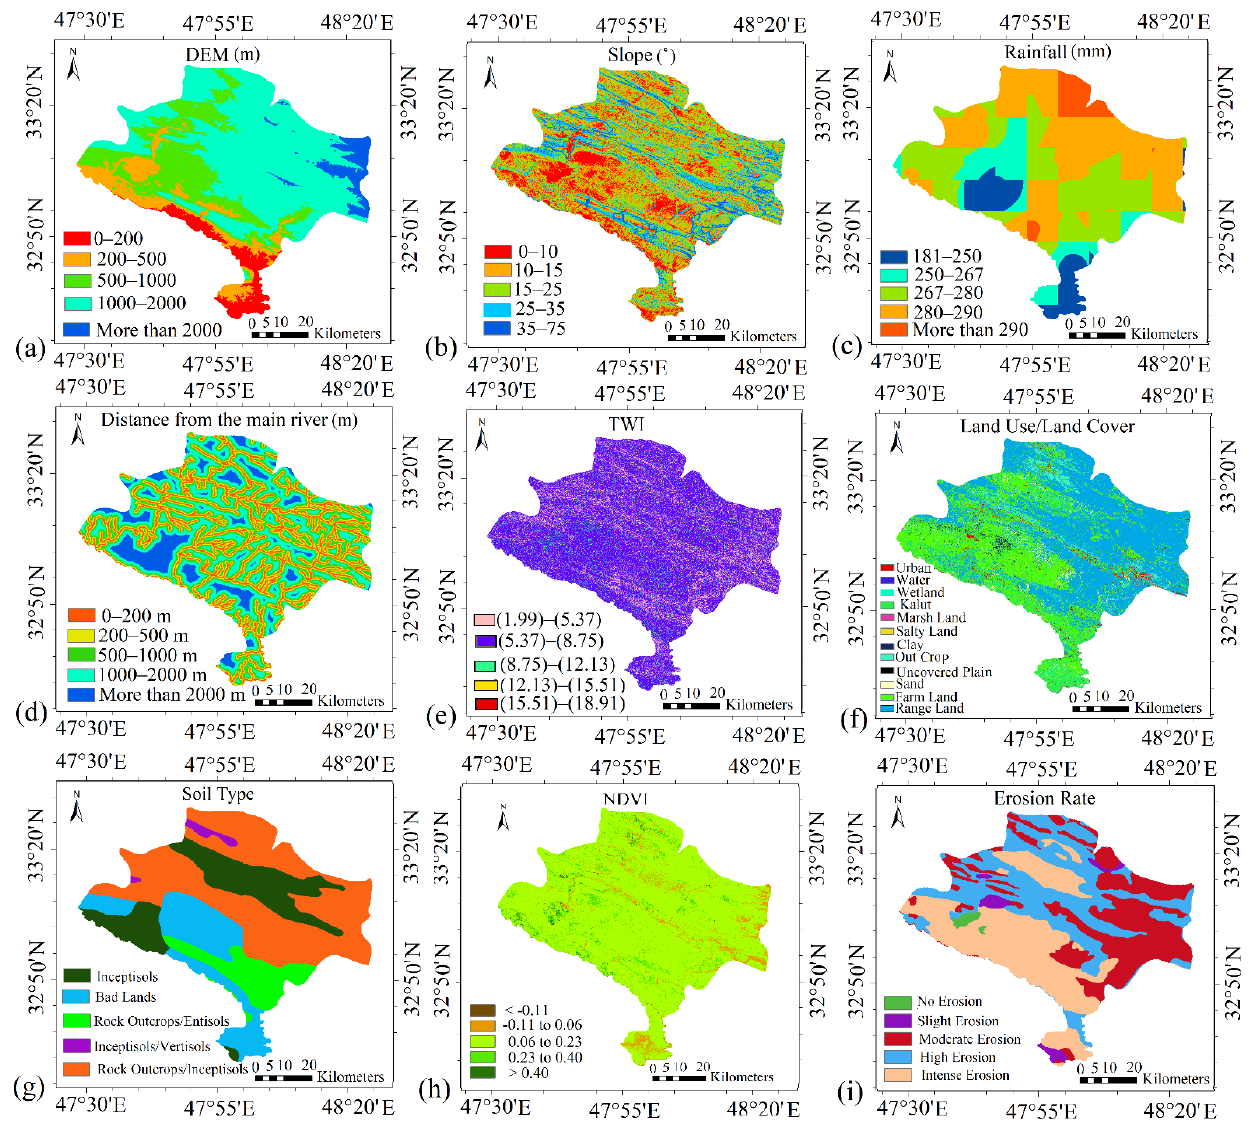
Figure 3. The parameters/maps which were used in the proposed flood hazard system: ( a ) Digital Elevation Model (DEM), ( b ) slope, ( c ) rainfall, ( d ) distance from the main river, ( e ) Topographic Wetness Index (TWI), ( f ) Land Use/Land Cover (LULC), ( g ) Soil Type, ( h ) Normalized Difference Vegetation Index (NDVI), and ( i ) erosion rate.